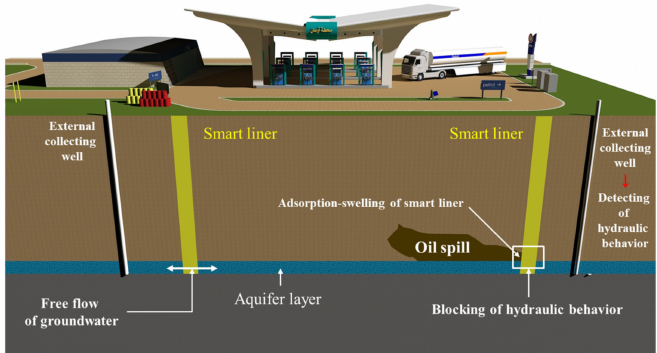
Figure 1. Installation of the smart liner and behavior in the ground with oil